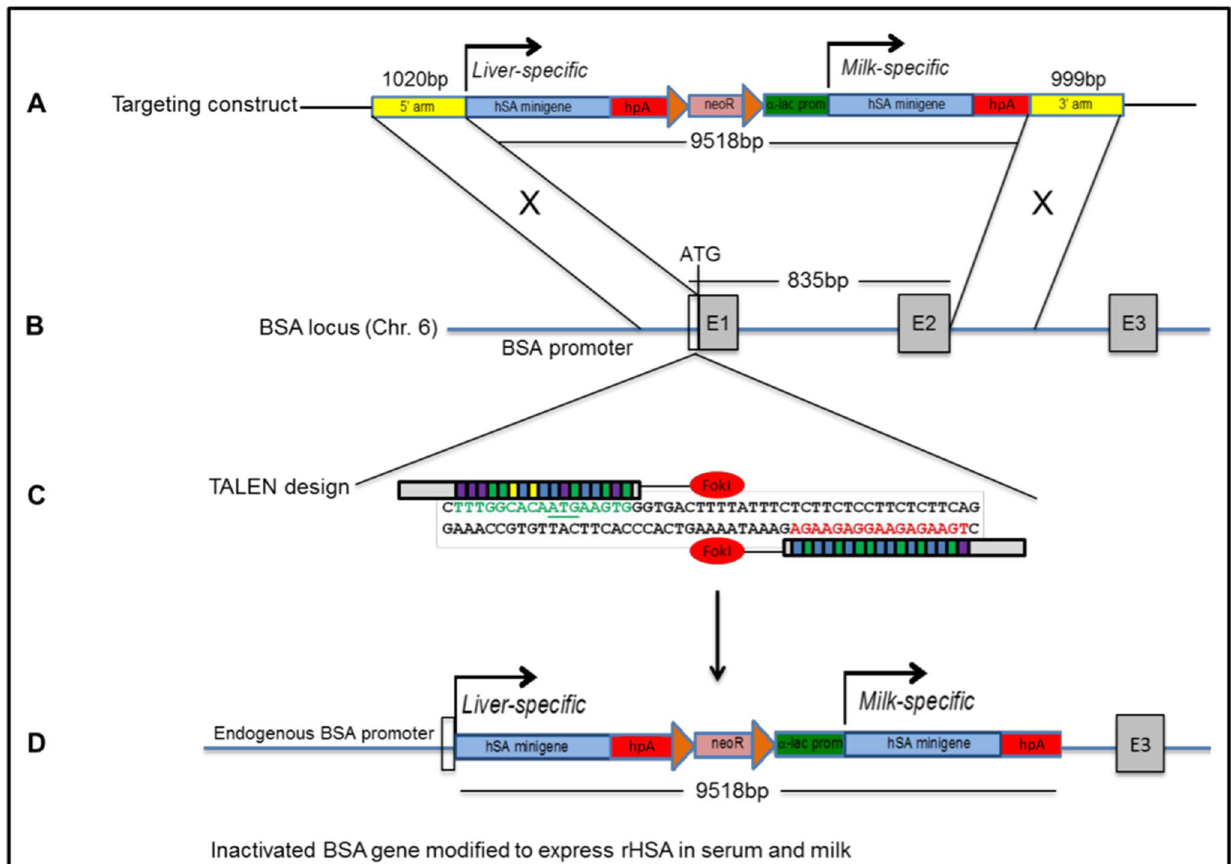
Figure 1. Humanizing the bA locus using TALEN-stimulated HDR. (A) Structure of the 11.5-kb pHSA-neo targeting construct containing two HSA minigenes and 1 kb targeting arms. The bovine a -lactalbumin promoter/regulatory region is 2 kb in size. Diagram is not drawn to scale. (B) Structure of the bA gene on chromosome 6. Targeting arms are homologous to a region immediately upstream of the endogenous 5 9 translation initiation codon and within intron 2 (C) Binding of the left and right TALENs. TALE repeats are color-coded to represent each of four repeat variable di-residues (RVDs); each RVD recognizes one corresponding DNA base (NI =A, NG =T, HD =C, NN =G). DSBs are expected to be produced in the 15- bp spacer region in order to stimulate HDR. (D) Proper recombination will result in the deletion of an 835-bp region of DNA, removing bovine exons 1, intron 1, and exon 2, thereby disrupting endogenous bA gene expression and replacing the 5 9 coding region of the bA gene with two copies of an HSA minigene. HSA1 will be driven by the endogenous bA promoter and will direct rHSA expression to the liver; HSA2 will be expressed in the milk under the a -lactalbumin promoter/regulatory region.